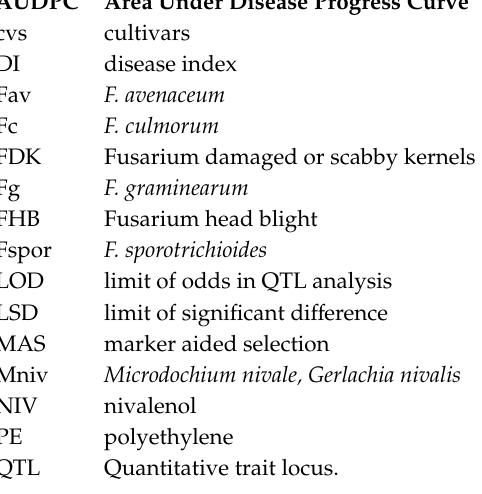
Figure S1. Disease index data (%) in the methodical test for inoculation methods across years and methods according to epidemic severities, 2009–2012. Figure S2. FDK data (%) in the methodical test for inoculation methods across years and methods according to epidemic severities,